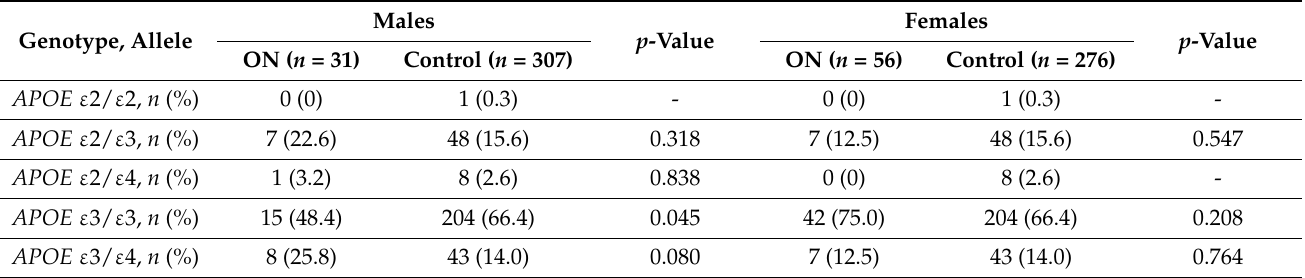
Table 4. APOE genotype and allele frequencies in patients with ON and controls grouped by